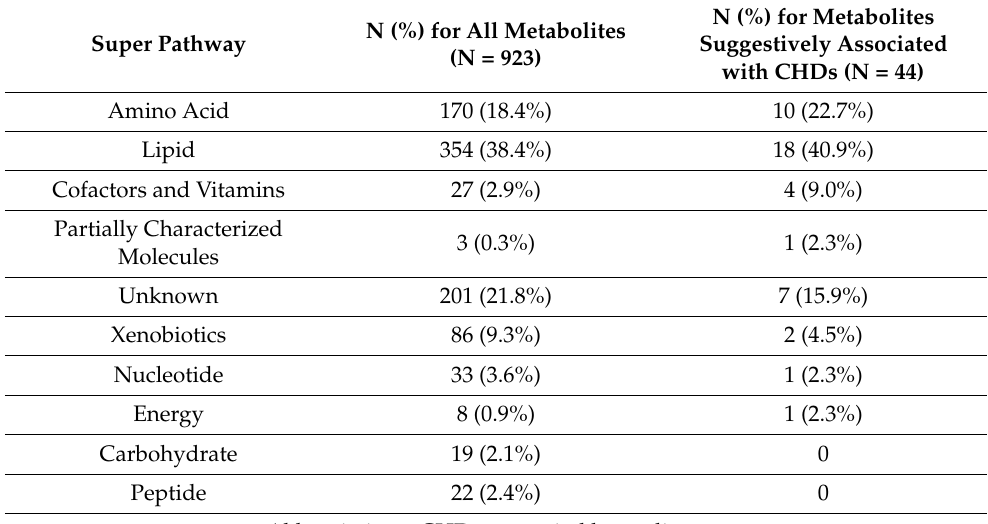
Abbreviations: CHD, congenital heart